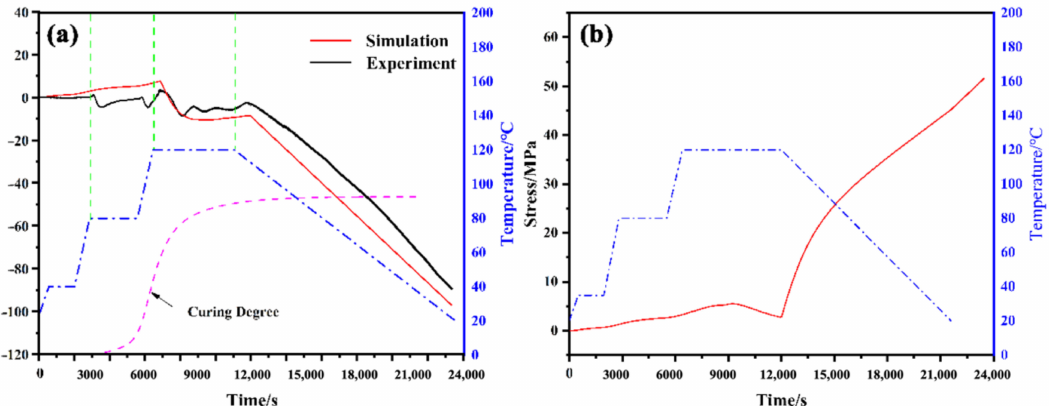
Figure 7. ( a ) The evolution of stress at Point A obtained by simulation and experiment; ( b ) The evolution of stress at the center of the surface aluminum